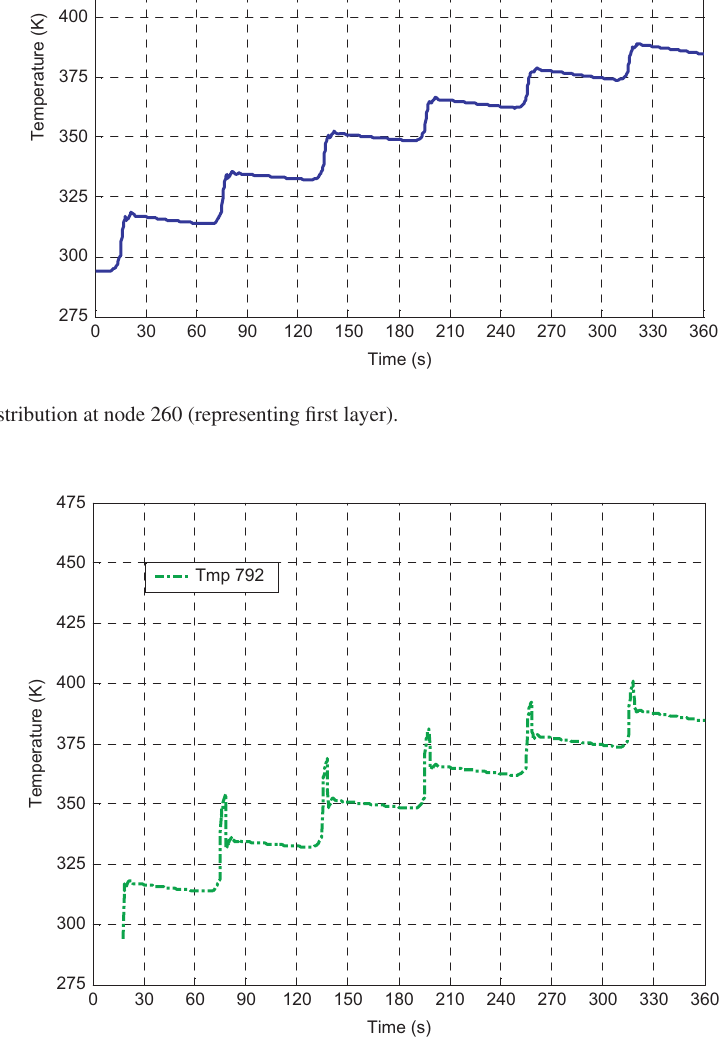
Figure 10 Temperature distribution at node 792 (representing second layer).